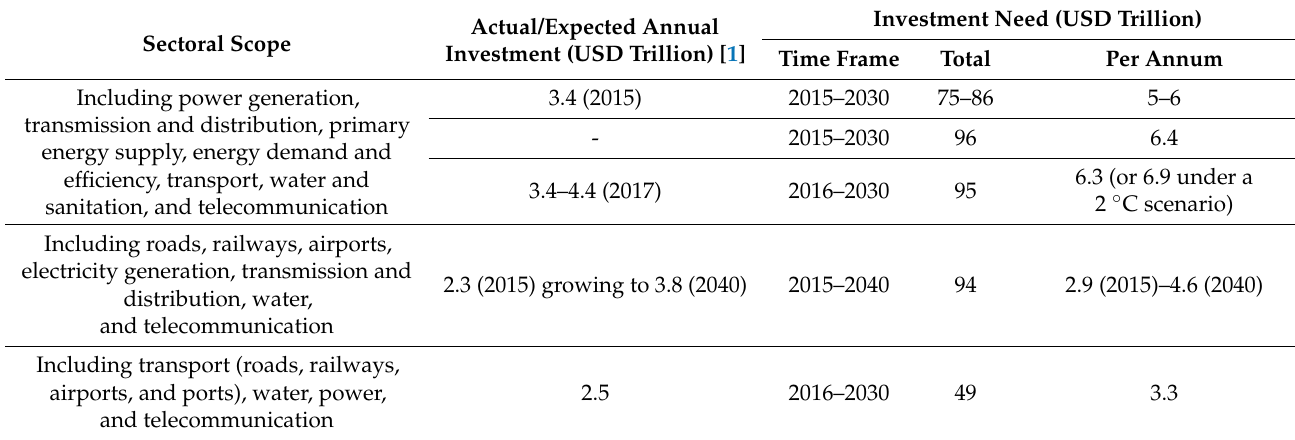
Table 1. Comparison of the estimates of global infrastructure investment